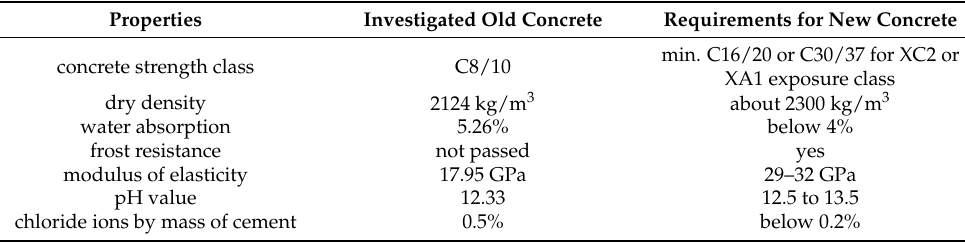
Table A1. Comparison between the chosen properties for the investigated old concrete and require- ments for the new